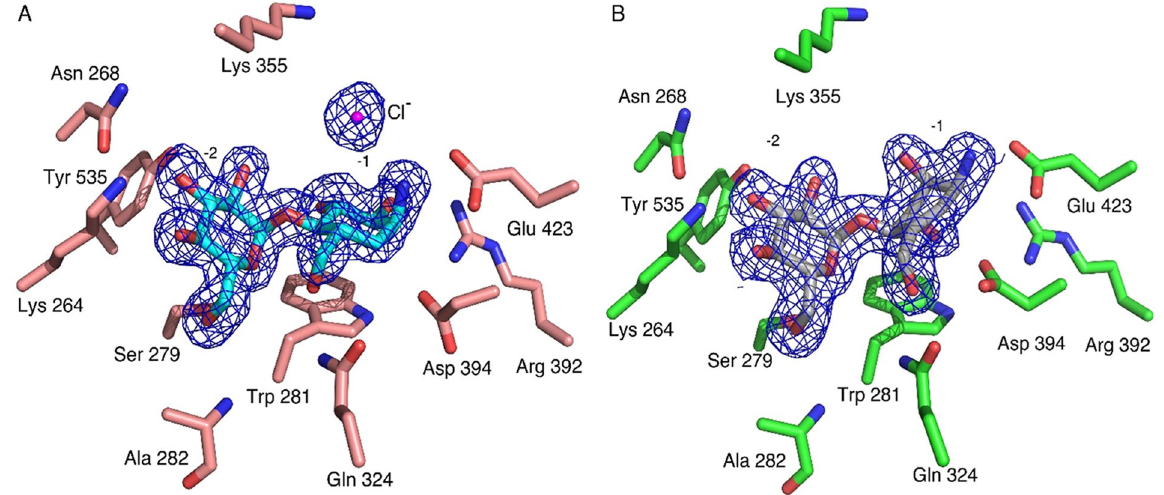
Figure 4. Compounds 7 and 8 bound in the active site of Sco GlgE1-V279S. ( A ) Complex of Sco GlgE1-V279S with 7 . The magenta sphere represents the ordered chloride ion. ( B ) Complex of Sco GlgE1-V279S with 8 . Both 2F O − F C composite omit maps are contoured at 1.5σ.